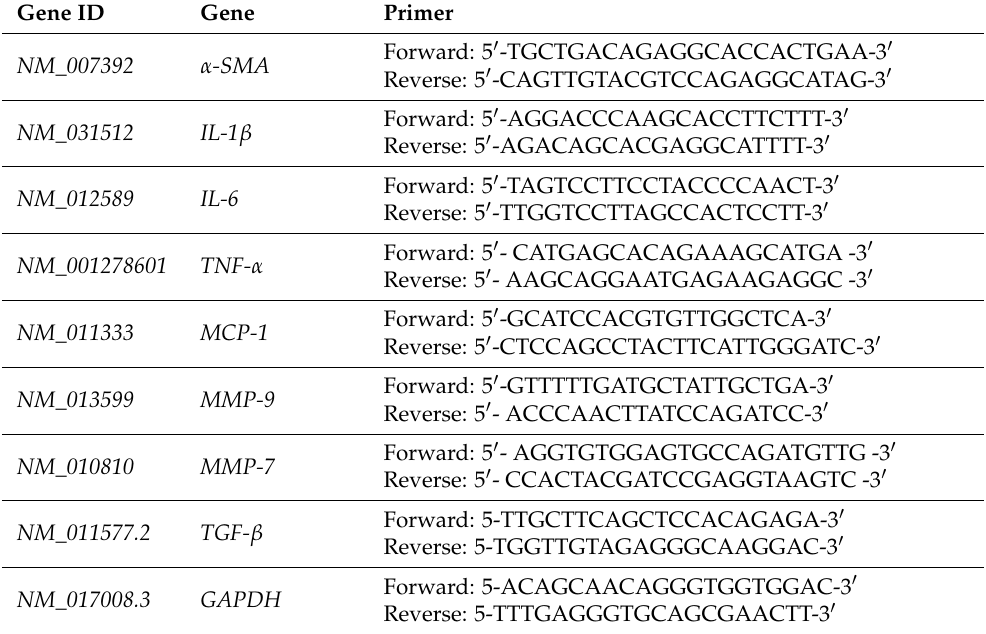
Table 1. Primers used to amplify target